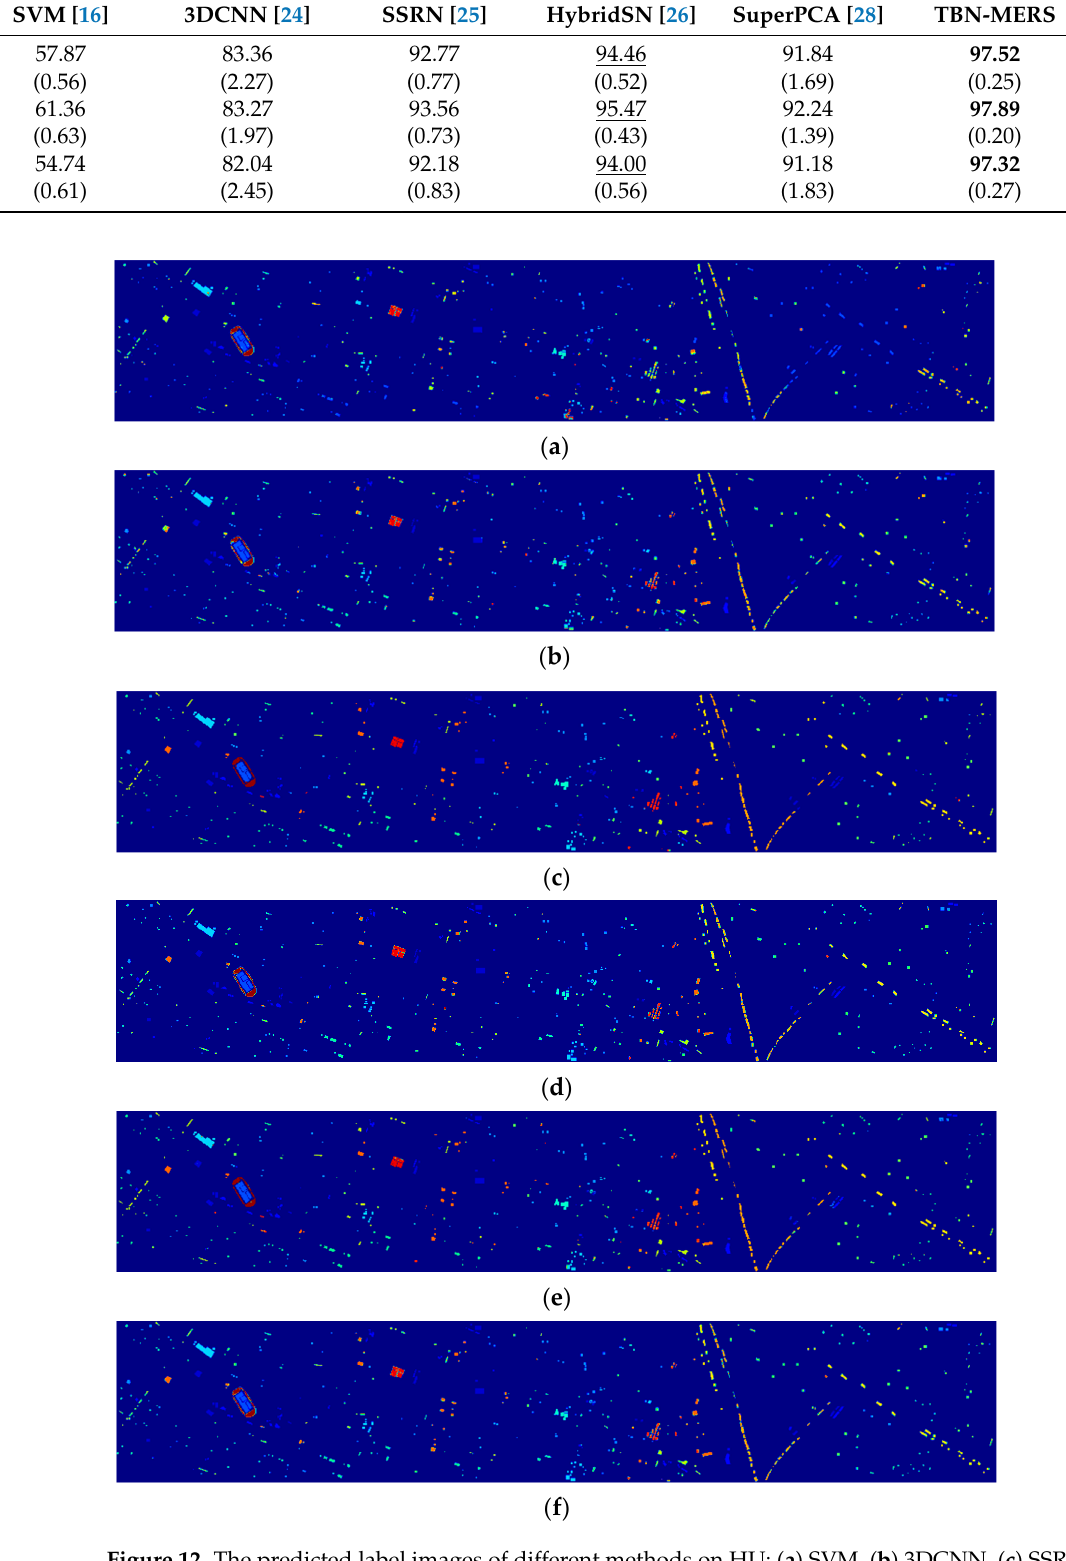
Figure 12. The predicted label images of different methods on HU: ( a ) SVM, ( b ) 3DCNN, ( c ) SSRN, ( d ) HybridSN, ( e ) SuperPCA, and ( f ) TBN-MERS.